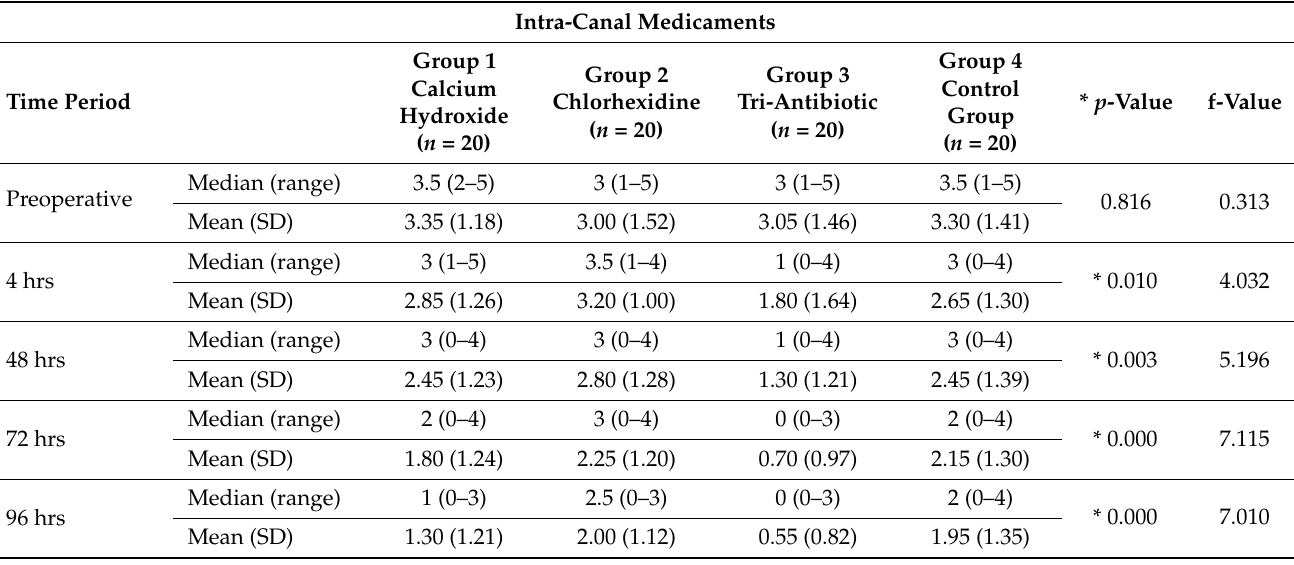
Table 2. Median (range) and mean ( ± SD) pain (WFPRS) scores in the four groups.